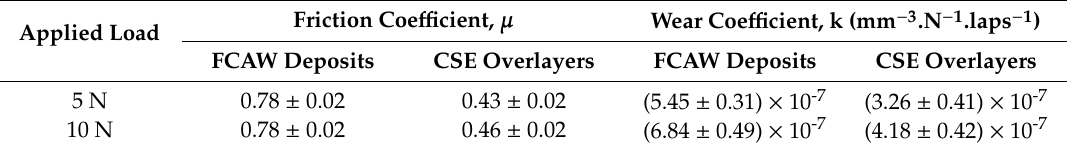
Figure 15. Top view SEM micrographs of the worn surface of the “solar” hardfacing layers, after ball-on-disk testing for 200,000 sliding revolutions, applying a normal load of 10 N. Table 3. Ball-on-disk tribological performance of conventional FCAW deposits, compared to CSE overlayers [27].